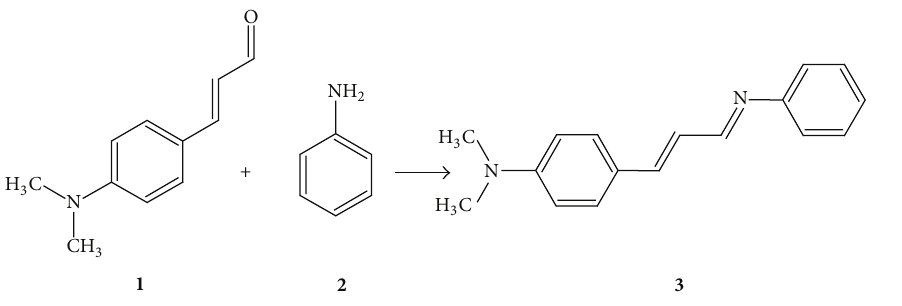
Scheme 1: Synthesis of the Schiff base ligand (SBL).